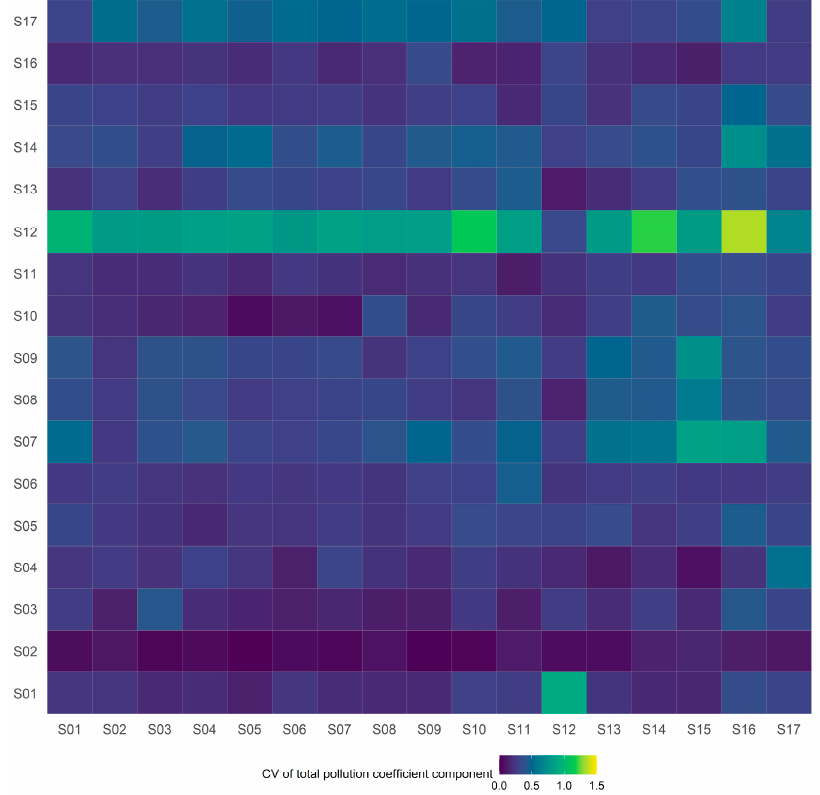
Figure A1. The CV of China’s TPCC matrix of the EF in 2005, 2010, and 2015.